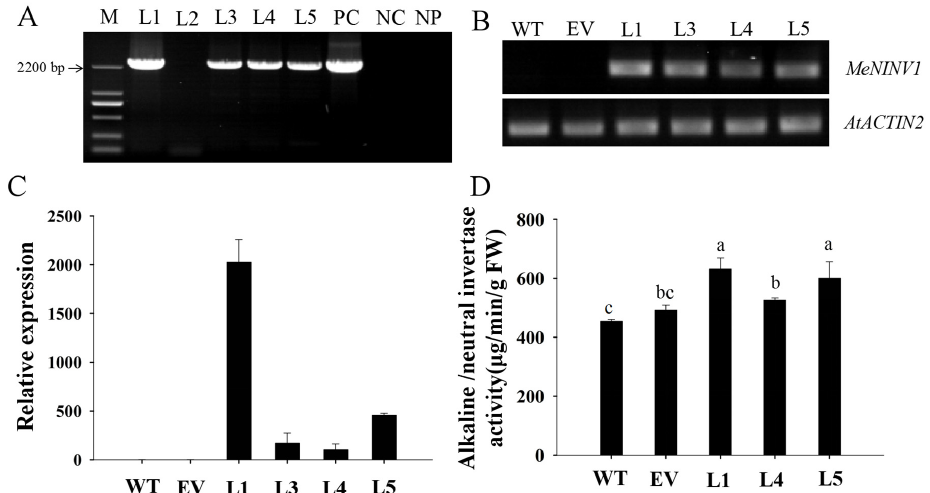
Figure 5. Identification of MeNINV1 transgenic Arabidopsis lines. ( A ) PCR detection of T1 transgenic Arabidopsis , M—DL2000 marker; L1–5—transgenic plants; PC—positive control of pCAMBIA1300- MeNINV1-GFP vector; NC—negative control of WT; NP—no template PCR. ( B ) Semiquantitative RT– PCR of MeNINV1 in T1 transgenic Arabidopsis lines. AtACTIN2 was the reference gene. ( C ) The related expression levels of MeNINV1 in T1 transgenic Arabidopsis lines. AtACTIN2 was the reference gene, and the relative expression of MeNINV1 in WT was used as a calibrator to compare with other lines for map- making. ( D ) A/N-Inv activity in leaves of WT and transgenic Arabidopsis. In ( B – D ): WT—wild-type Arabidopsis thaliana Columbia; EV—transgenic Arabidopsis with the pCAMBIA1300-GFP vector. Data in ( C , D ) are the mean ± SD of three independent assays. Significant differences were determined by one-way ANOVA followed by Duncan’s multiple range test at p < 0.05. Values labeled with different letters (a, b, and c) were significantly different.